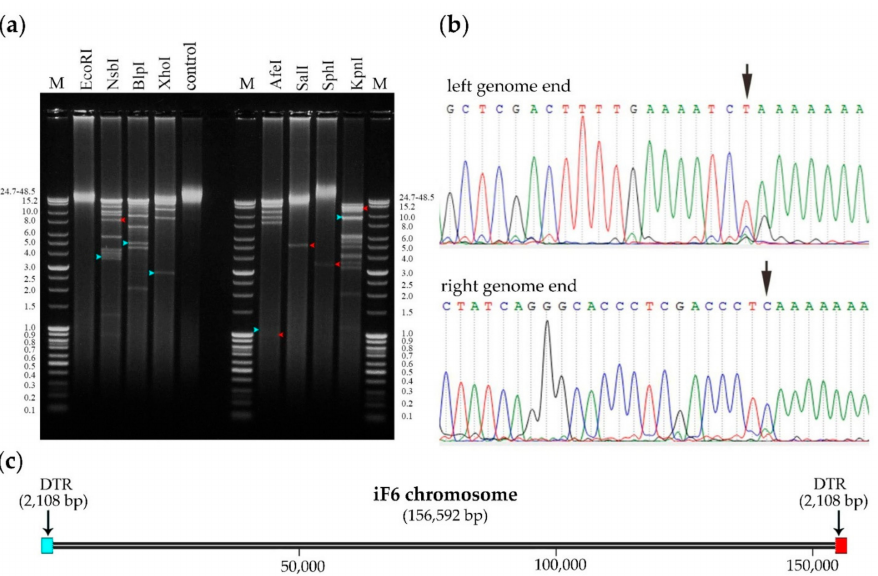
Figure 8. Determination of packaging mechanism and genome termini. ( a ) Restriction analysis of iF6 DNA. M—molecular weight markers; red and light blue arrows indicate fragments containing the right and left ends of the iF6 chromosome, respectively. The original full-length gel is presented in Supplementary Information, Figure S5. ( b ) Sequencing chromatograms of the terminal regions of the PCR product sequences obtained with RAGE for the left and right ends. ( c ) Schematic representation of the iF6 phage